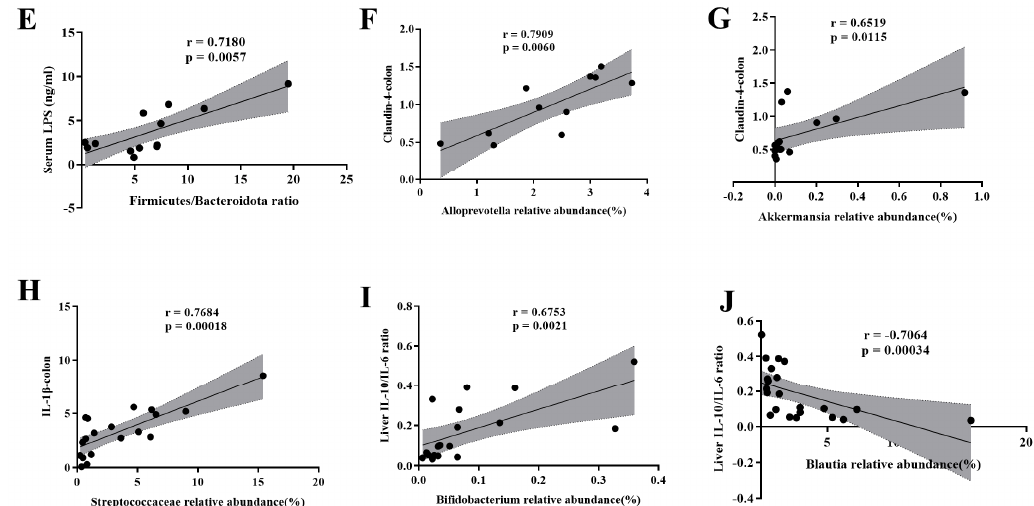
Figure 6. Spearman correlation analysis supports that SFN ameliorates HFHFr mice via the microbe– gut–liver axis. ( A ) Heatmap of the association between microbiota and some other experimental re- sults. The intensity of the color is proportional to the intensity of the Spearman correlation. ( B ) Serum LPS levels were negatively correlated with the relative abundance of Butyricicoccus . ( C ) Relative mRNA expression of Claudin-4 in the colon was positively correlated with the relative abundance of Butyricicoccus . ( D ) IL-10/IL-6 ratio in the liver measured by ELISA was positively correlated with the relative abundance of Butyricicoccus . ( E ) Serum LPS levels were positively correlated with the Firmicutes/Bacteroidota ratio. ( F ) Relative mRNA expression of Claudin-4 in the colon was positively correlated with the relative abundance of Alloprevotell . ( G ) Relative mRNA expression of Claudin-4 in the colon was positively correlated with the relative abundance of Akkermansia . ( H ) Relative mRNA expression of IL-1 β in the colon was positively correlated with the relative abundance of Streptococcaceae. ( I ) IL-10/IL-6 ratio in the liver measured by ELISA was positively correlated with the relative abundance of Bifidobacterium . ( J ) IL-10/IL-6 ratio in the liver measured by ELISA was negatively correlated with the relative abundance of Blautia . * p < 0.05, ** p < 0.01, *** p <